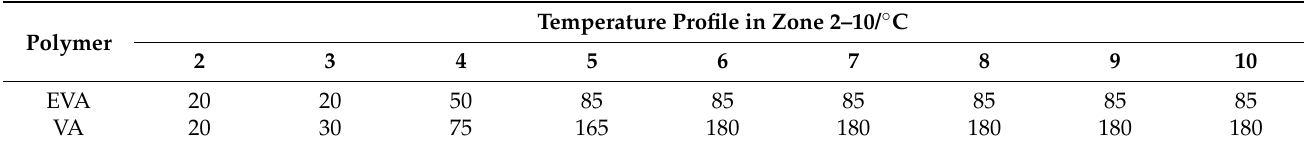
Table 1. Temperature profile of zones 2–10 for extrusion runs with selected polymers.